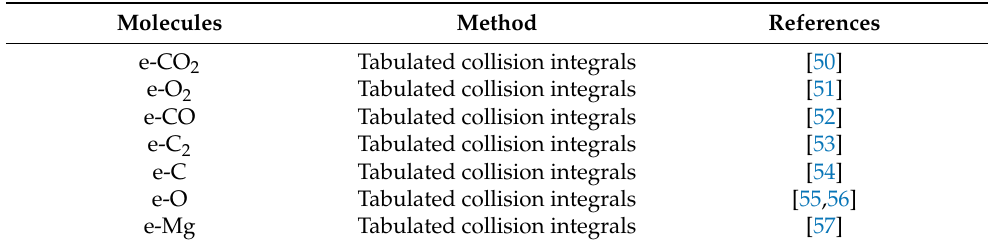
Table 4. Method and references for computation of collision integrals between electron and neu- tral